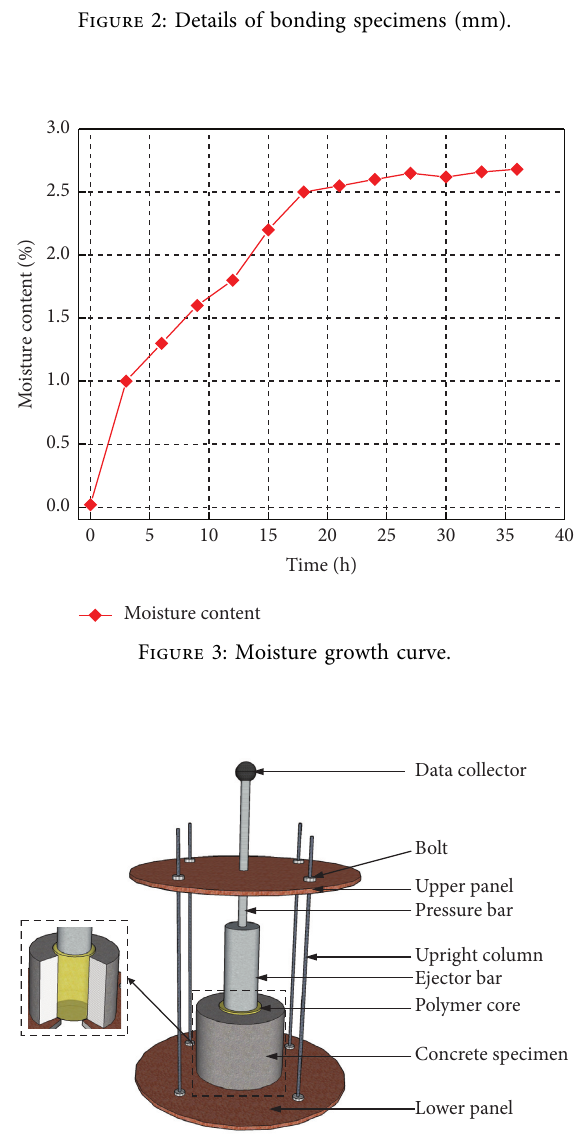
Figure 4: Experimental device.